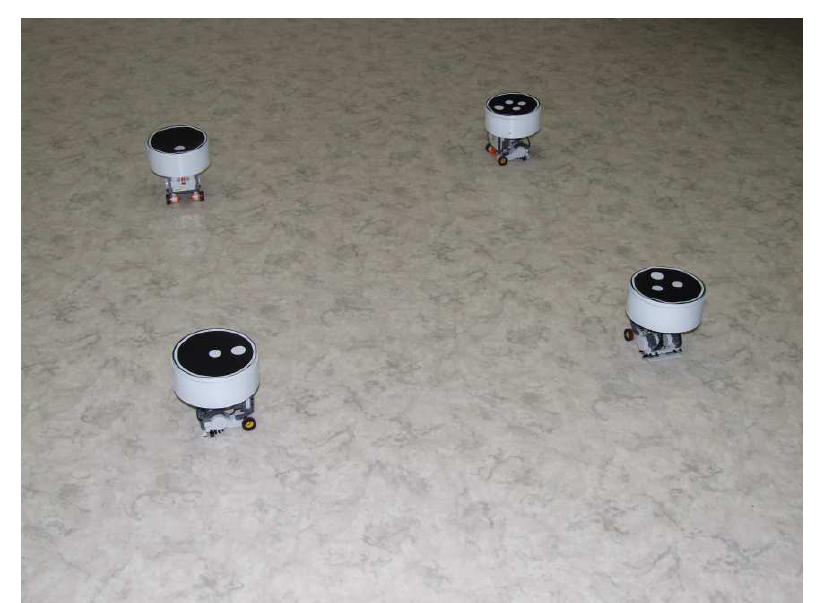
Figure 2. The LEGO NXT mobile